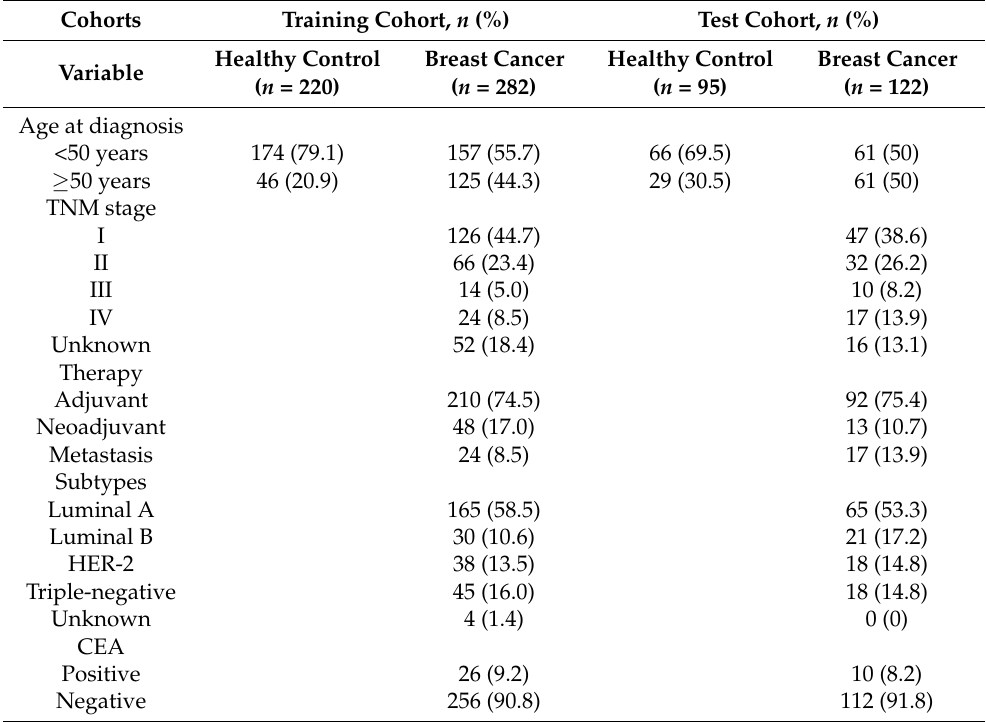
Table 1. Clinicopathologic characteristics of breast cancer patients.